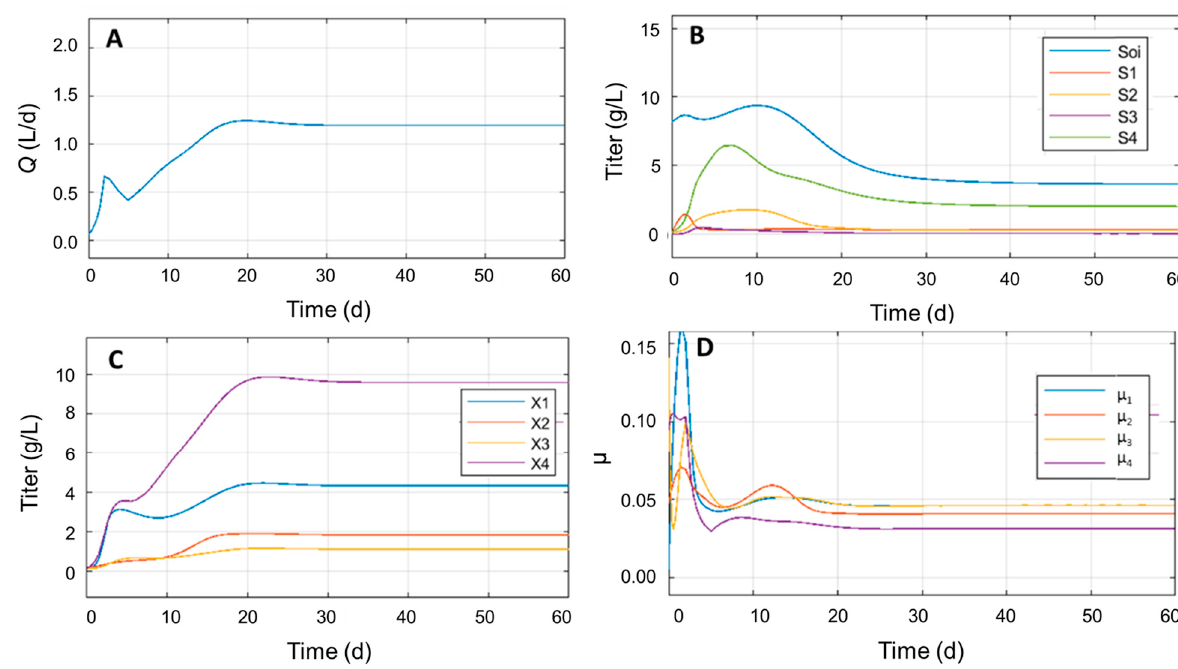
Figure 4. Simulation of biomethane yield over time (panel A ), compound titers (panel B ), microbial titers (panel C ), and microbial specific growth rates (panel D ) over time with updated equations, and D = 0.14 d − 1 .